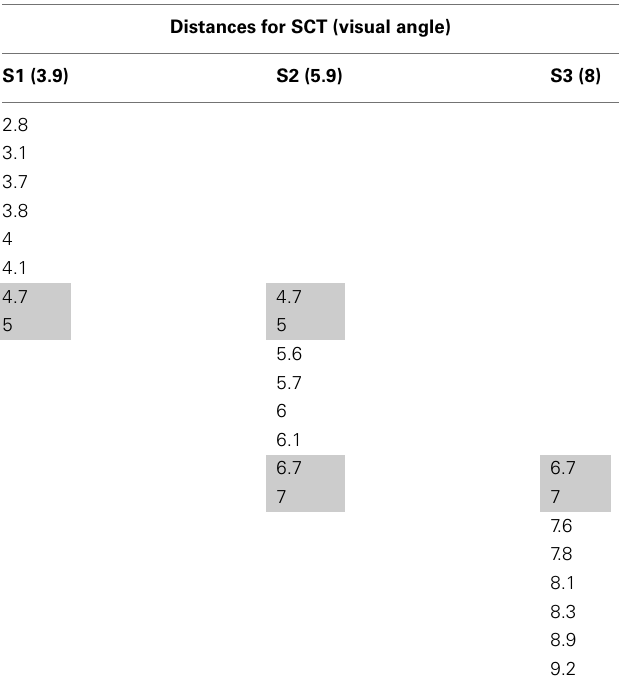
Table 2 | Distance values used in SCT with the